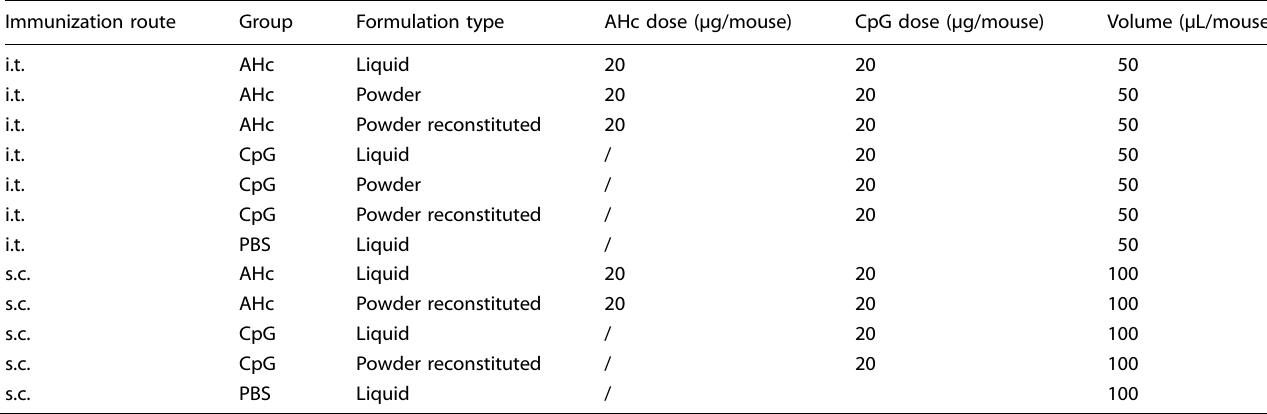
Table 2. Summary of all immunization groups in the